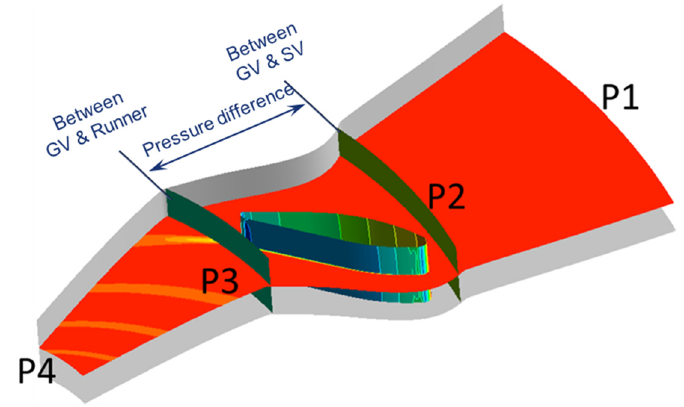
Figure 2. Pressure difference location for guide vane loss analysis.